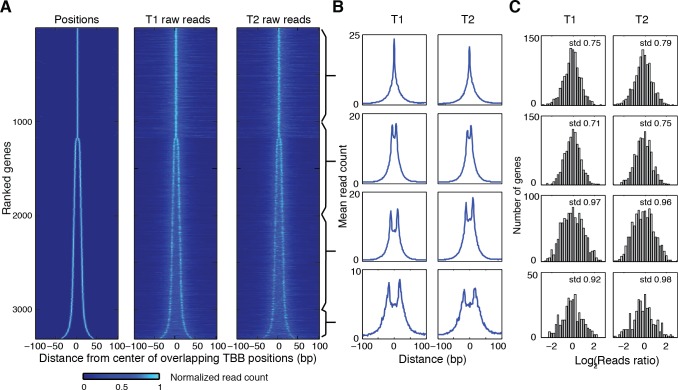
Heat map showing the TBB nucleosome positions and the midpoint read occupancy.(A) Heatmaps are the same as Figure 5C, except that the position clusters with more than 2 positions are excluded. (B) Plots show the average midpoint occupancy of genes in groups of 1000. (C) Bar graphs are the same as Figure 5—figure supplement 1, except that the clusters with more than 2 positions are excluded.